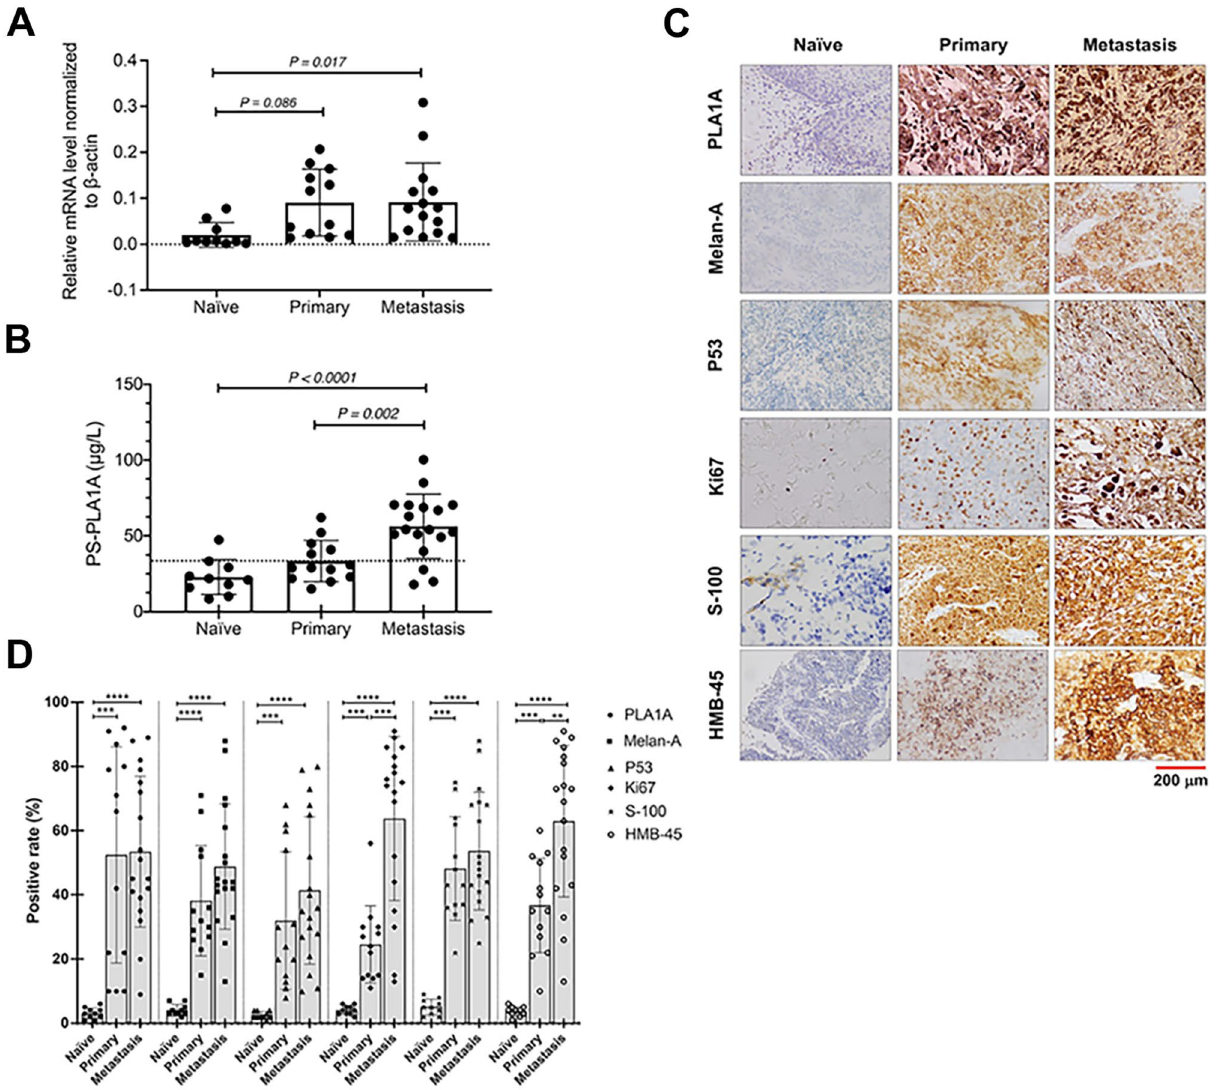
Figure 1. Analysis of PLA1A expression among different patient samples. ( A ) The expression of PLA1A in normal naïve/normal melanoma (n = 10), primary melanoma (n = 13) and metastatic melanoma (n = 18) tissues measured using TaqMan MicroRNA assays kit. ( B ) Comparison of serum PLA1A levels (PS-PLA1A) between naïve/normal melanoma (n = 10), primary melanoma (n = 13) and metastasis melanoma (n = 18). Representative histological staining imaging ( C ) and quantification of the relative expression ( D ) of an invasive and aggressive index of PLA1A, in comparison to the invasive panel, Ki-67+, S-100+, P53+, HMB-45+, and Melena + index of tumor sections in various groups. * p < 0.05 and ** p < 0.001 vs the naïve group; # p < 0.05 and ## p < 0.001 vs the primary